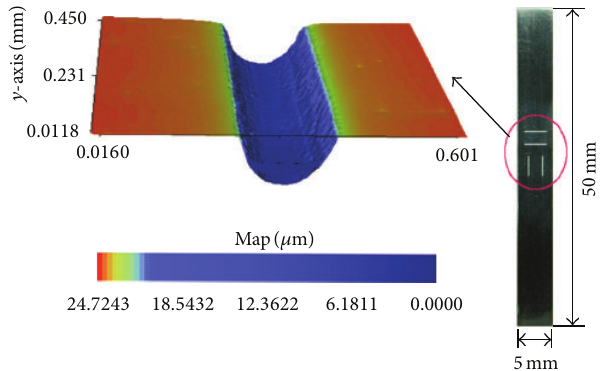
Figure 1: The geometry configuration of specimen and 3D surface profile at